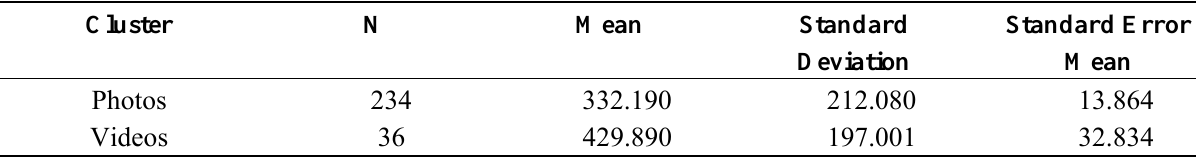
Table 11. Descriptive statistics: tweets with sentiment linking photos vs . videos (speed of retweeting). Cluster